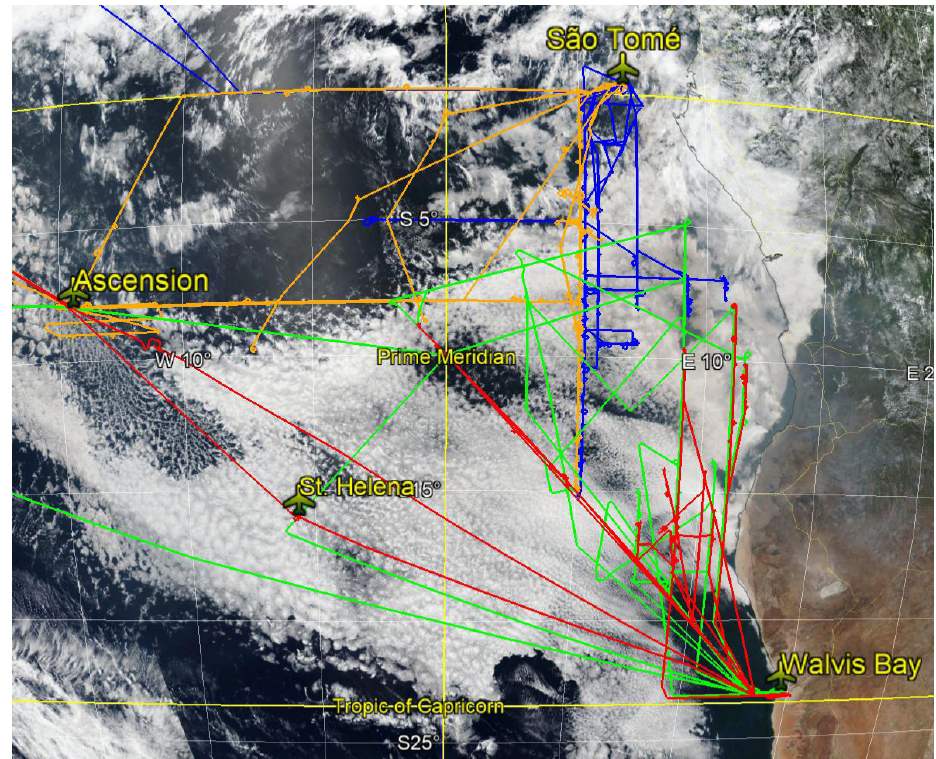
Figure 11. Flight tracks of the ORACLES aircraft in 2016 to 2018, overlain on a MODIS-Aqua True Color Image acquired on 13 Septem- ber 2018. ER-2 flight tracks in 2016 (only deployment year) are shown in green, adapted from © Google Maps 2020. P-3 flight tracks in 2016, 2017, and 2018 are shown in red, orange, and blue, respectively. The 2018 P-3 flight tracks are offset by 0.1 ◦ in longitude to allow distinction from 2017 flight tracks.